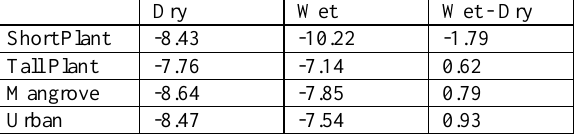
Figure 4. Diagrams of both GRD and SLC data preprocessing steps. The left column is for GRD and the right one is for SLC data resepectively.